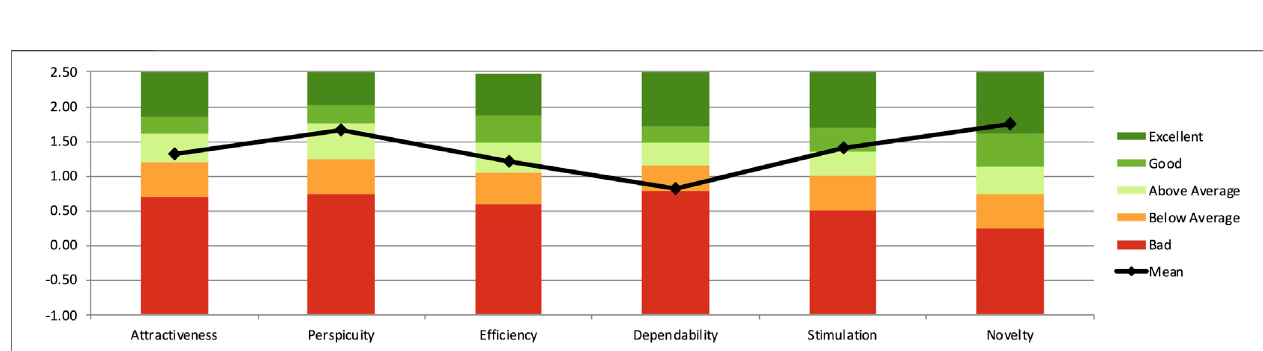
FIGURE 12 | User Experience Questionnaire results of the VR video editor set in relation to existing values from a benchmark data set [Containing feedback from 20190 persons from 452 studies concerning different products (business software, web pages, web shops, social networks), (Hart (2006))].